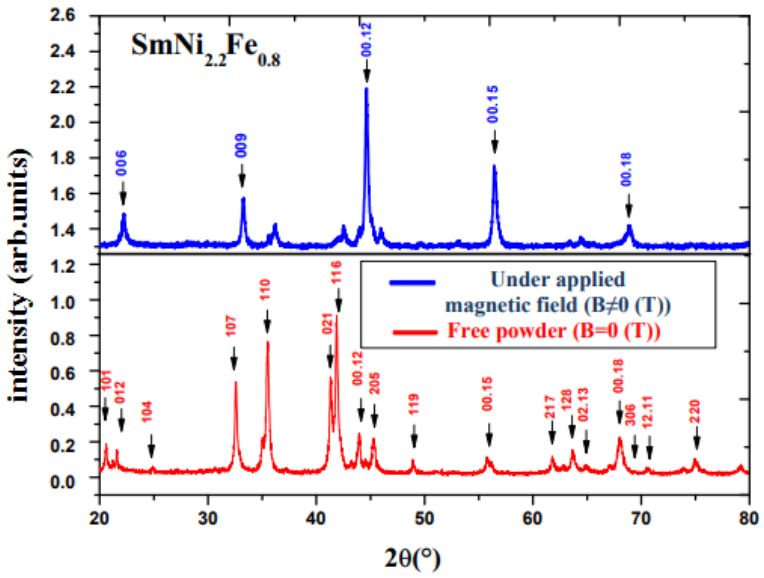
Figure 3. X-ray diffraction of free and oriented powder for SmNi 2.2 Fe 0.8